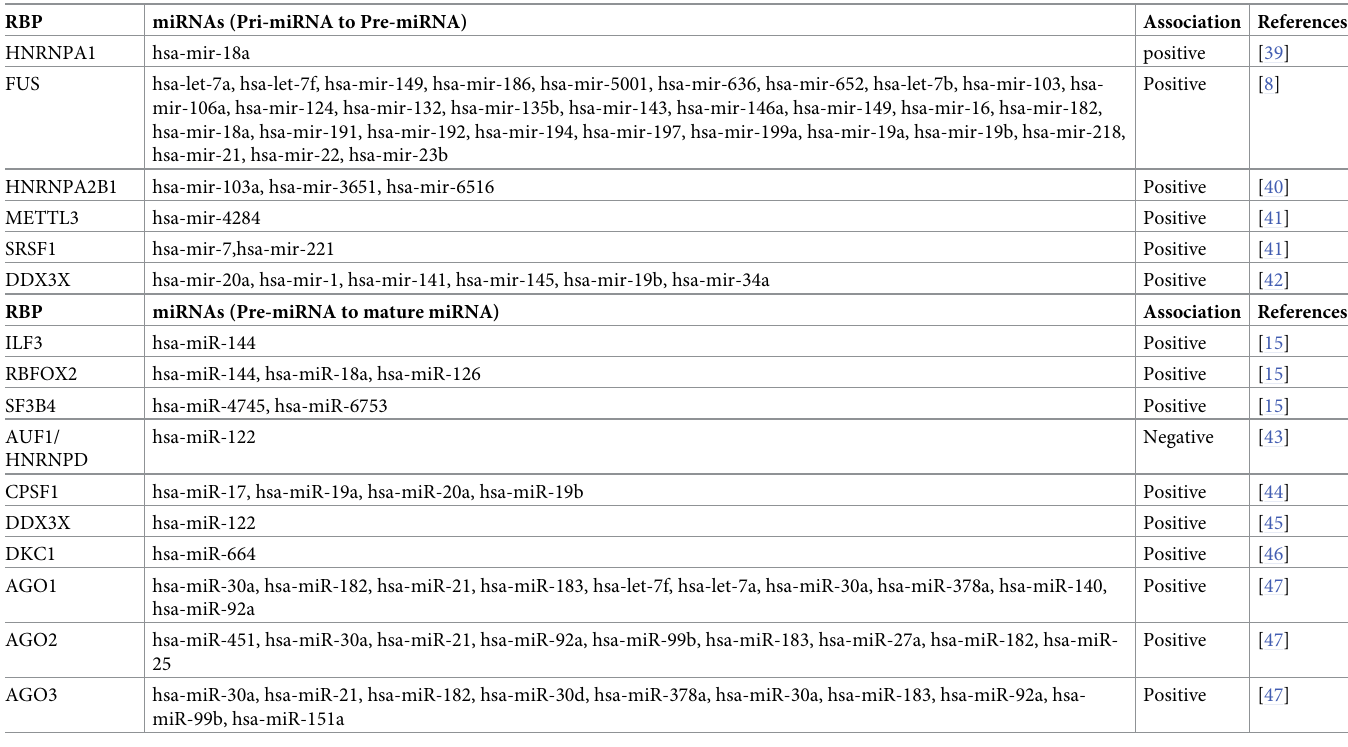
Table 2. Experimentally validated miRNA: RBP associations collected from various literature. RBP miRNAs (Pri-miRNA to